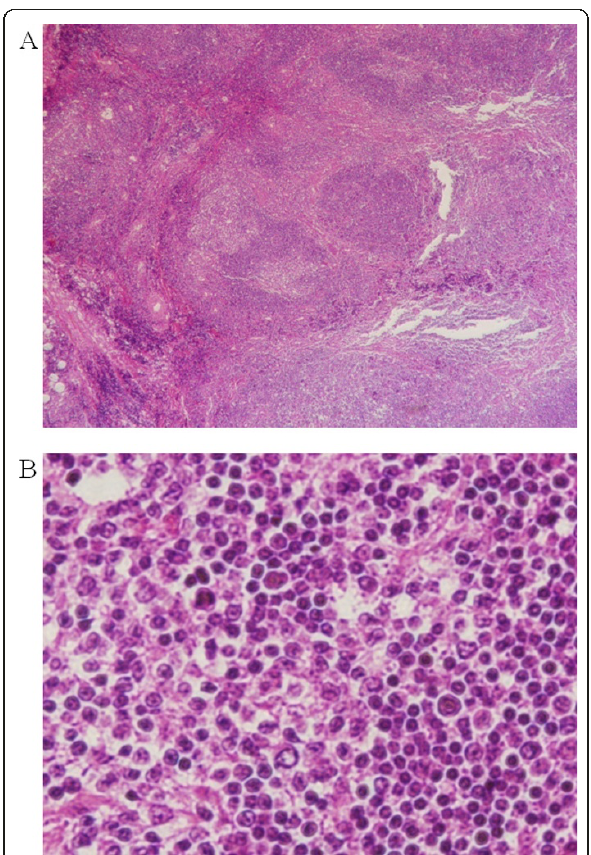
Figure 1 Light microscopic examination of primary tumor . Low- power magnification (×50) show some colonized lymphoid follicles with mantle zone in the primary MALT lymphoma (A). High-power magnification (×630) show centrocyte-like cells, monocytoid B-cells, and neoplastic cells which have Dutcher body in the primary MALT lymphoma